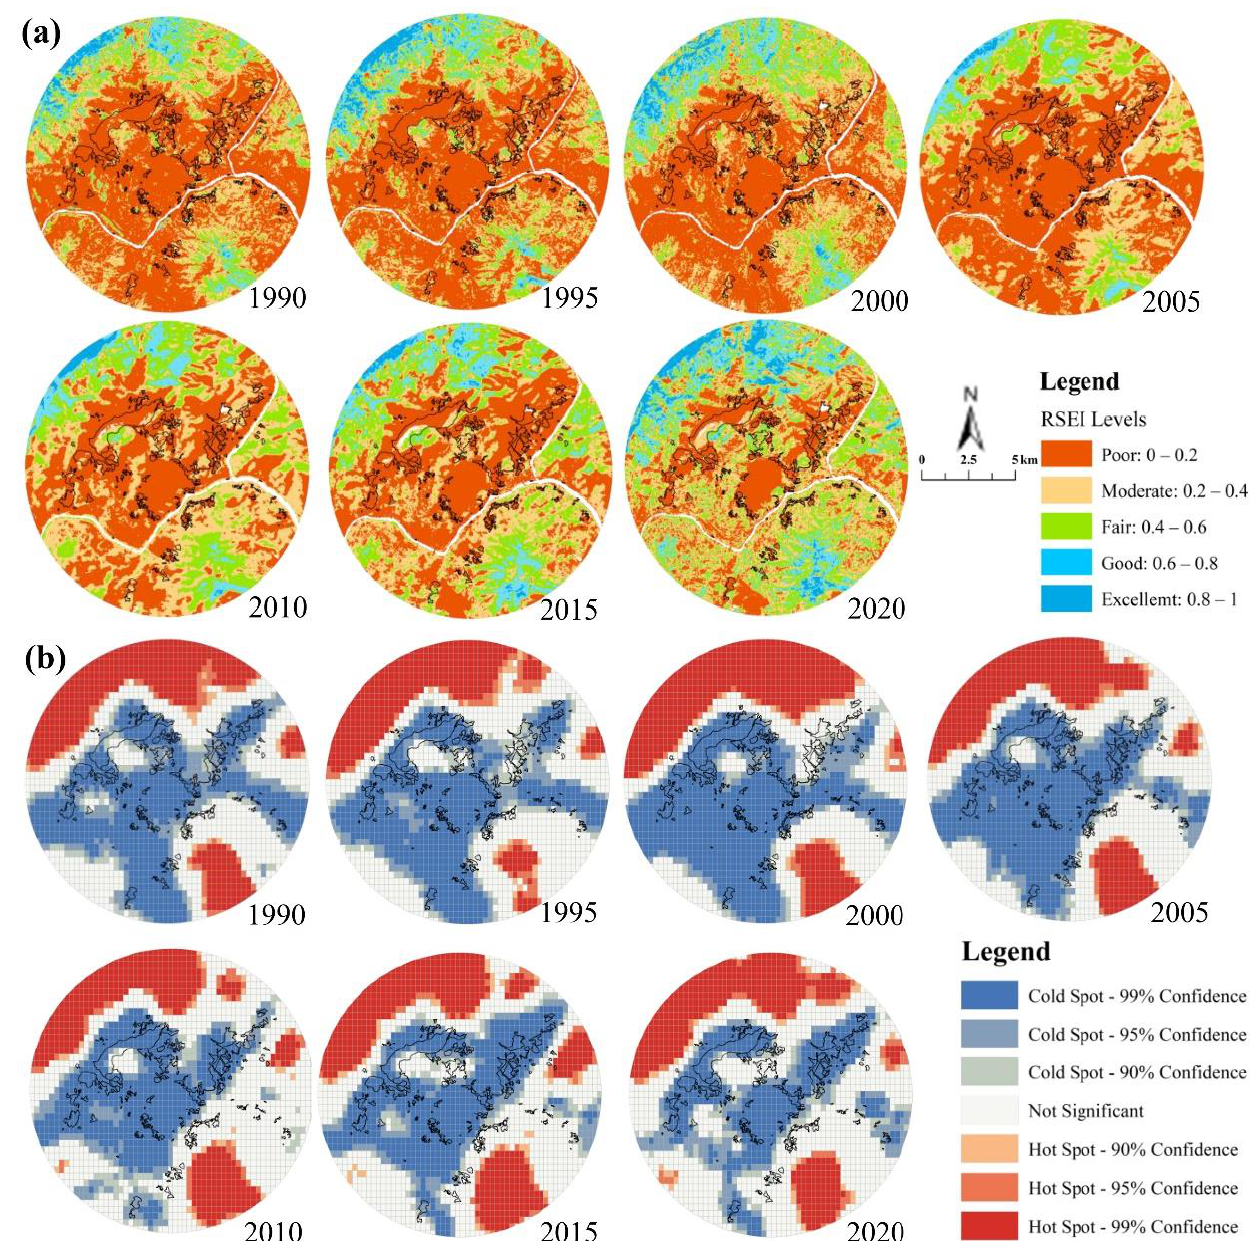
Figure A2. Spatial Distribution of RSEI and Hotspots and Coldspots in Panjiatian Mine (( a ): Spatial Distribution of RSEI, ( b ): Spatial Distribution of Hotspots and Coldspots).